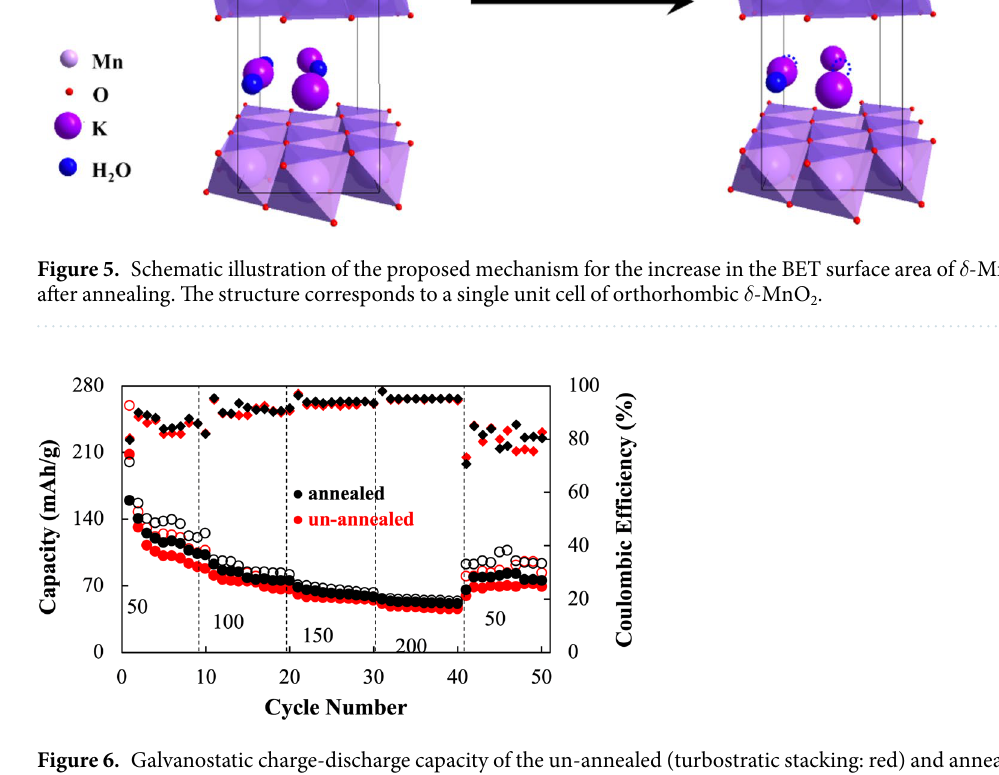
Figure 6. Galvanostatic charge-discharge capacity of the un-annealed (turbostratic stacking: red) and annealed (well-ordered stacking: black) samples at different current densities. The hollow and filled circles correspond to charge and discharge values respectively, while diamond corresponds to the coulombic efficiency